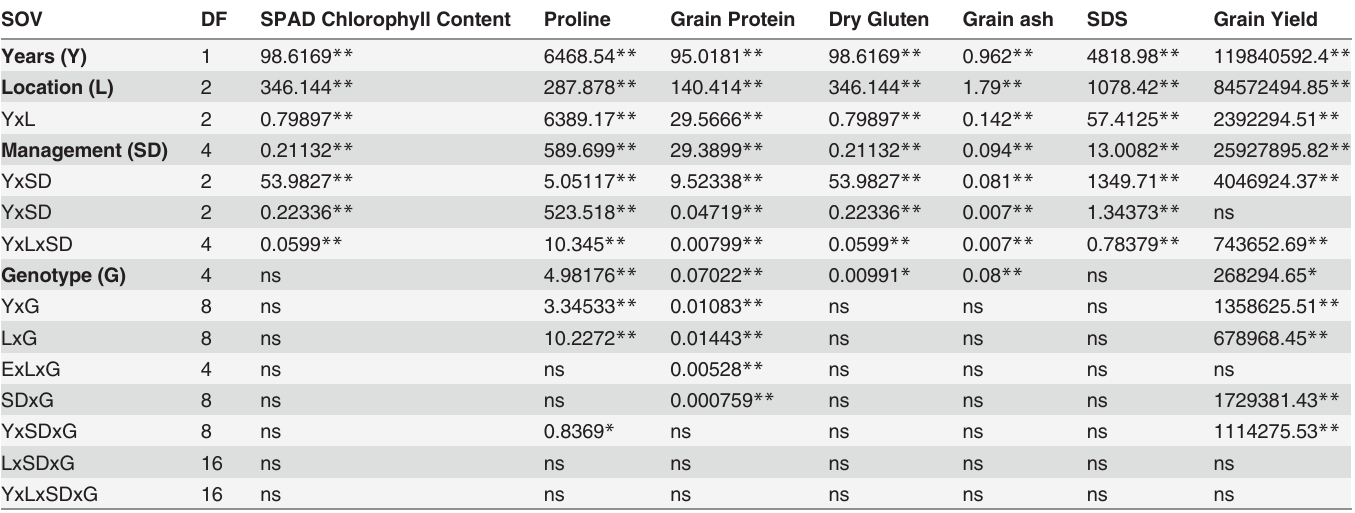
Table 1. Summary of mean squares of quality traits and grain